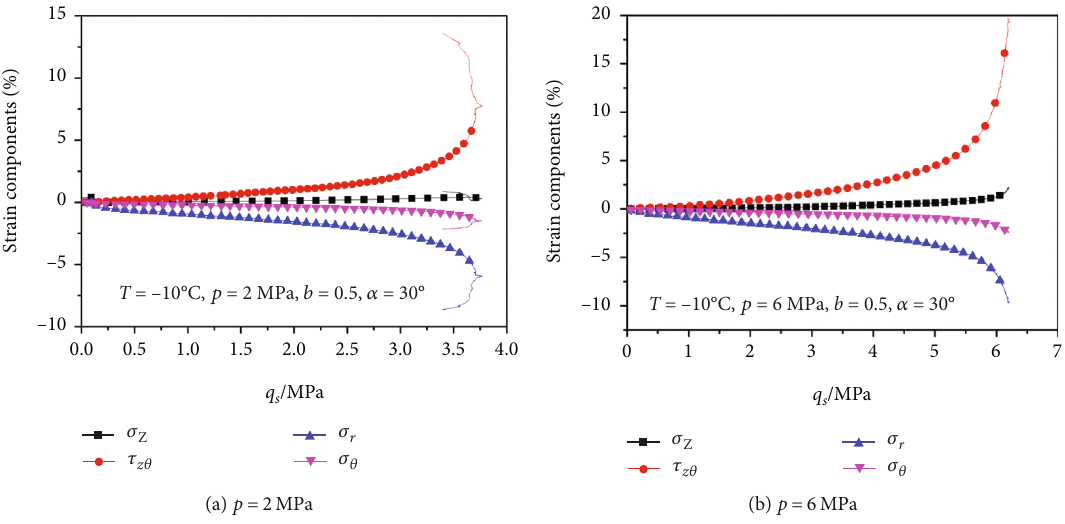
Figure 11: Relationships between shear stress and strain components of the